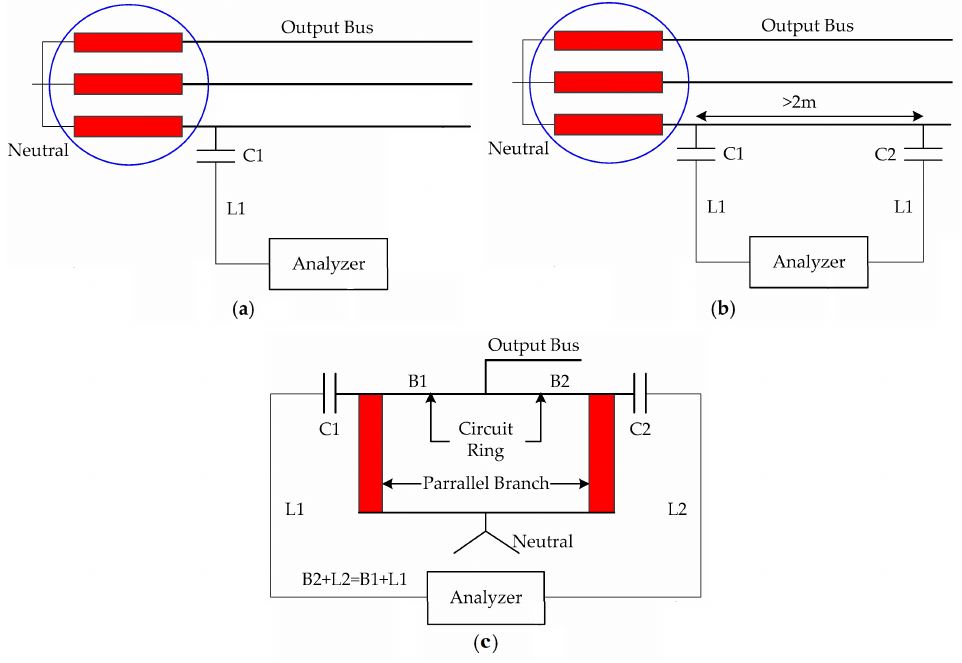
Figure 4. Configurations ( a ) simple, ( b ) directional and ( c ) differential, adapted from